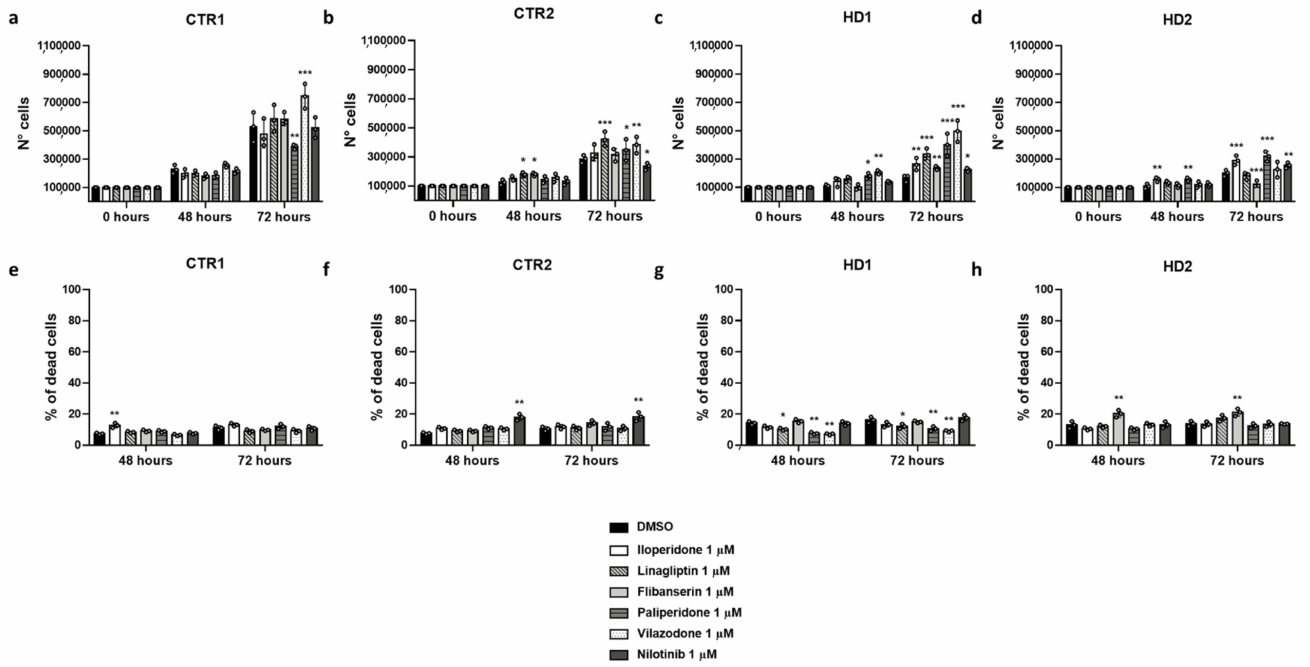
Figure 7. Effect of iloperidone, linagliptin, flibanserin, paliperidone, vilazodone and nilotinib on CTR1 ( a ), CTR2 ( b ), HD1 ( c ) and HD2 ( d ) cell growth, and percentage of dead cells in CTR1 ( e ), CTR2 ( f ), HD1 ( g ) and HD2 ( h ) cell lines. Fibroblast numbers were determined by direct counting of stained and unstained cells after 48 and 72 h and plotted against culture time. Data are shown as mean ± SD. * p < 0.05, ** p < 0.01, *** p < 0.0001, compared with DMSO treatment (Two-way ANOVA, followed by uncorrected Fisher’s LSD for multiple comparisons). Table 9. Percentage CTR1, CTR2, HD1 and HD2 dead fibroblasts at 48 and 72 h after